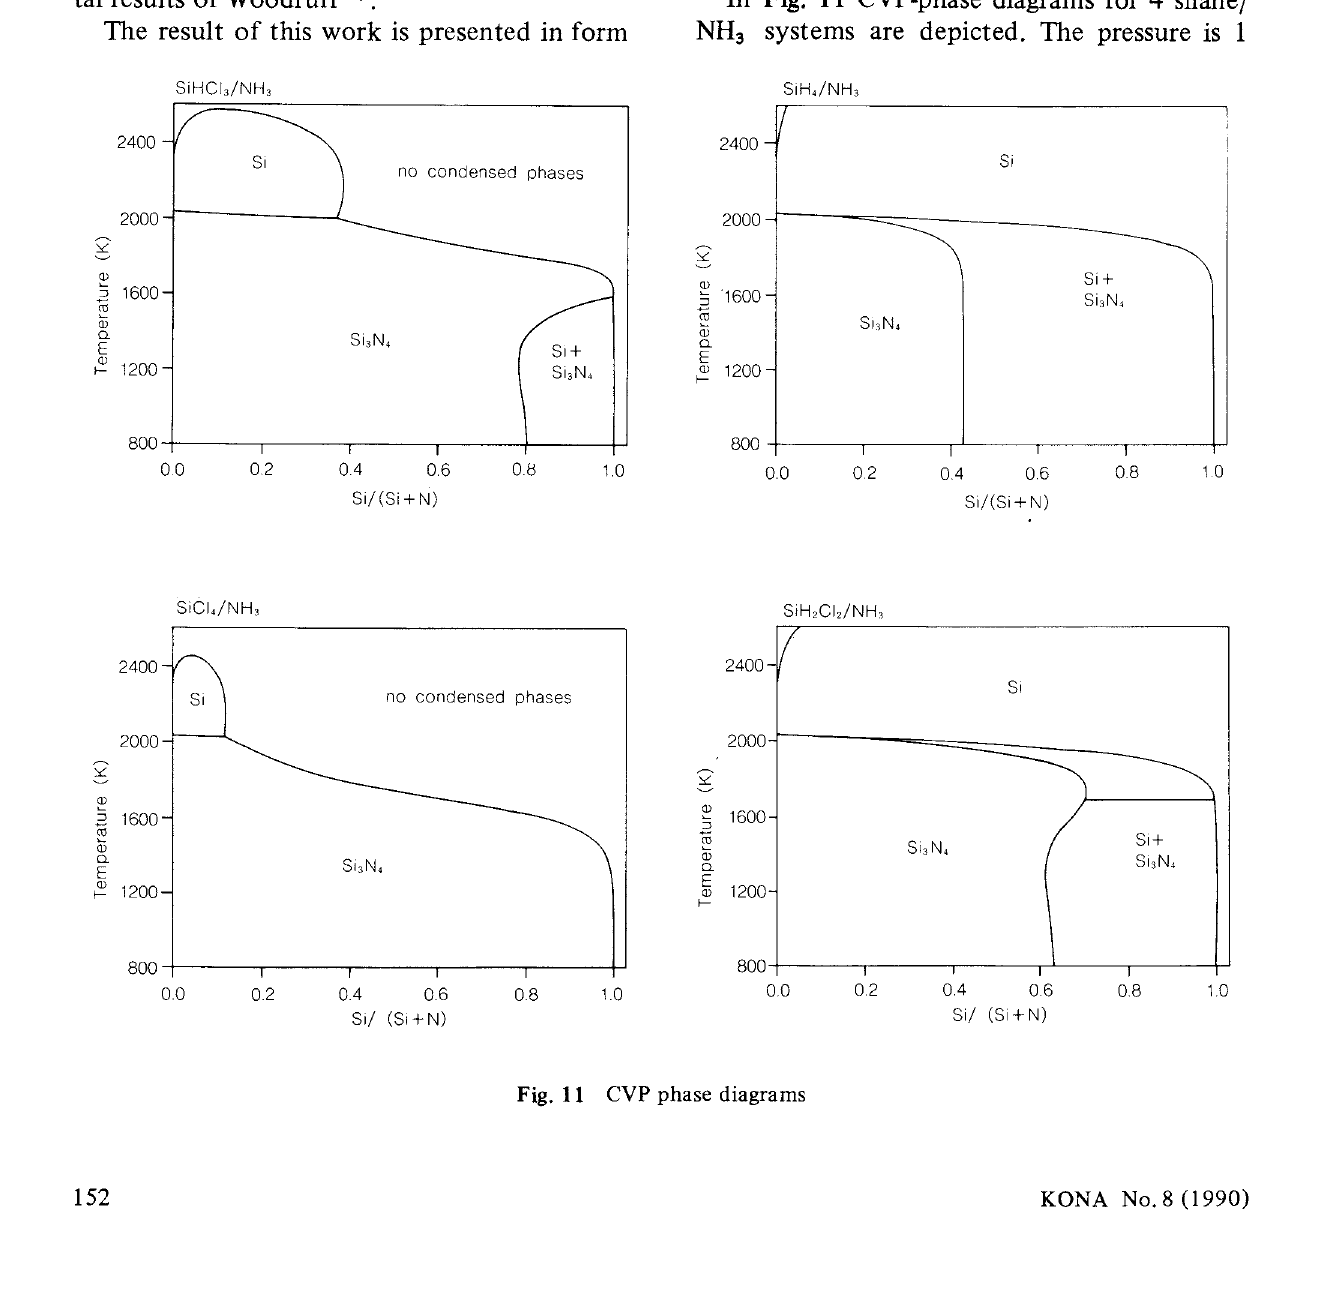
Fig. 11 CVP phase